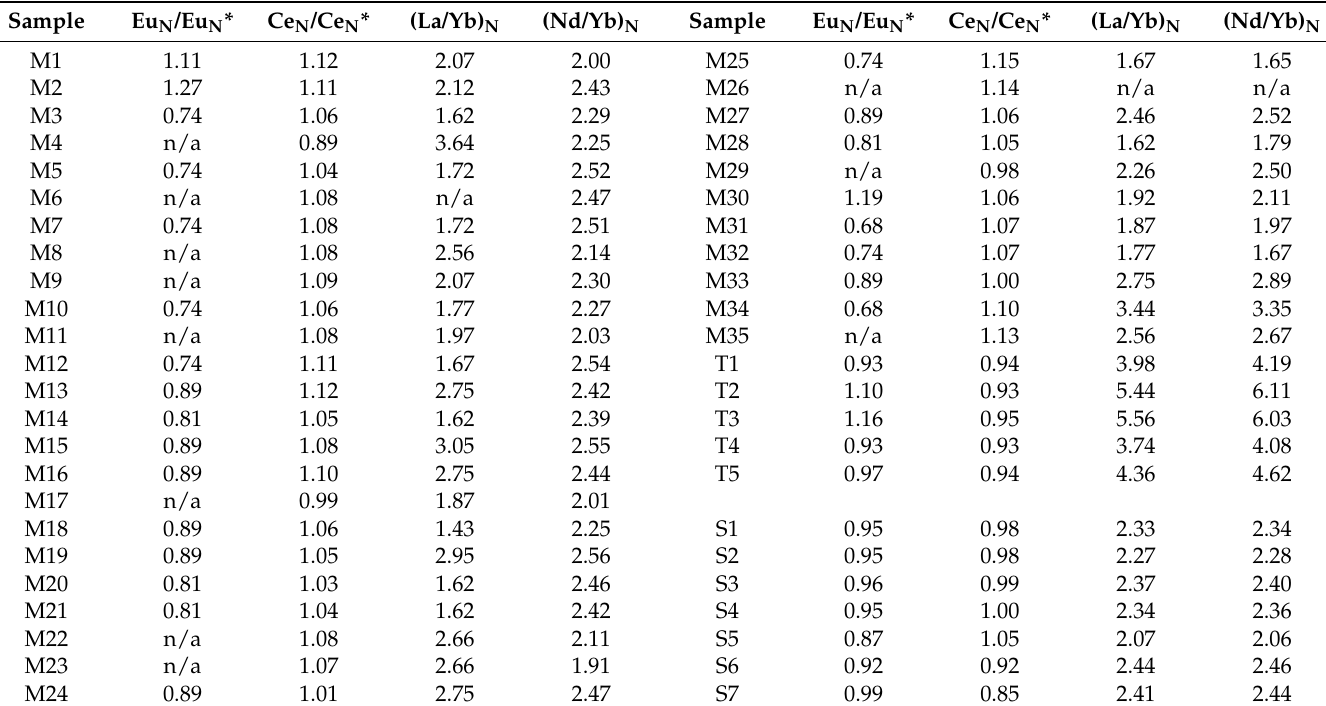
Table 2. Calculated anomalies and fractionation indices for studied